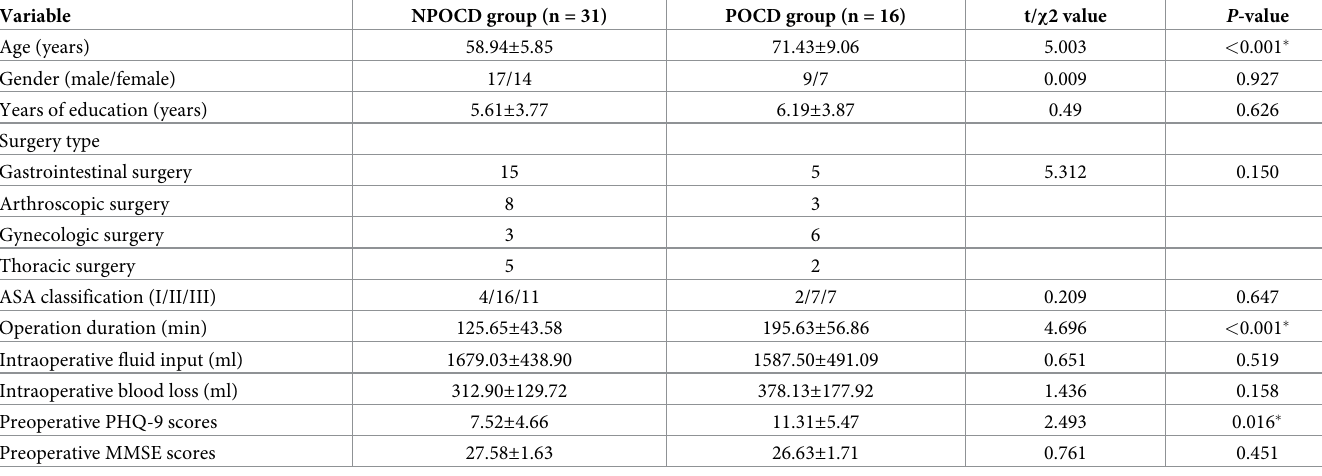
Table 4. The general characteristics of NPOCD and POCD